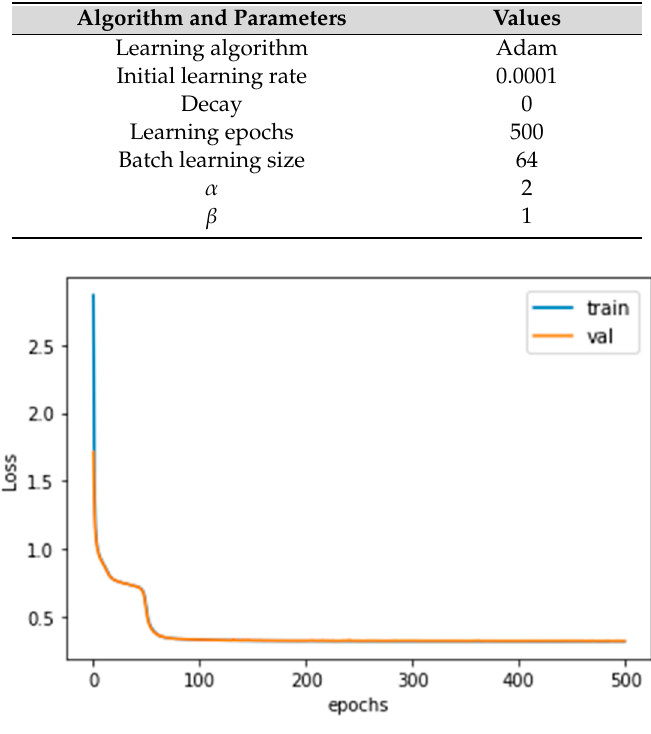
Figure 17. Feature clustering chart. In order to evaluate the estimation performance of the proposed method, the test gear entire wear process data were used for estimation. The estimated value was plotted with time as shown in Figure 18 to simulate obtaining pieces of data over time. As it can be seen that the variations in estimated values were positively correlated with wear time, and the final estimated and actual wear amounts were about 2.240 μ m and 2.471 μ m, respectively, which were the average values of 10 points. The estimation error was about 0.231 μ m, which is about 10%, and shows the ability of the proposed method.